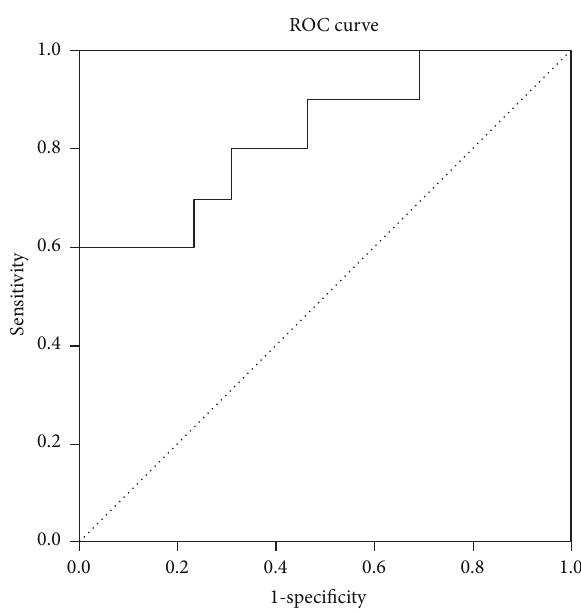
Figure 2: The ROC curve of DM patients with